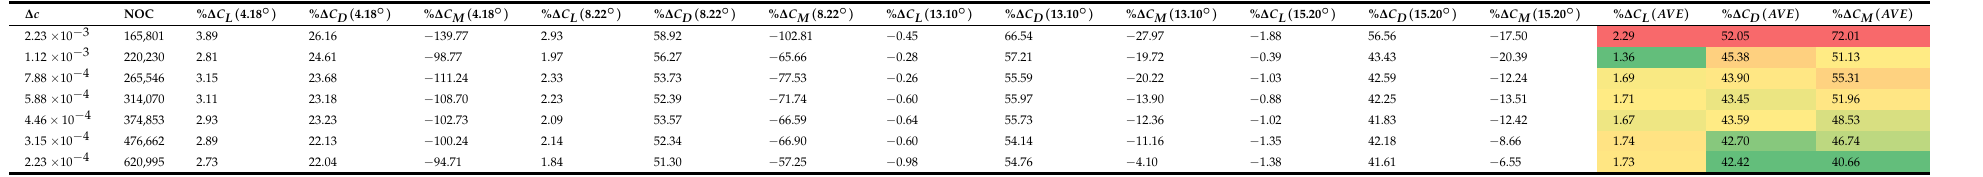
Table 12. Comparison of results of Hybrid-mesh based on various chord-wise spacings with that of experimental benchmark data adopted from [25] in relative differences. ∆